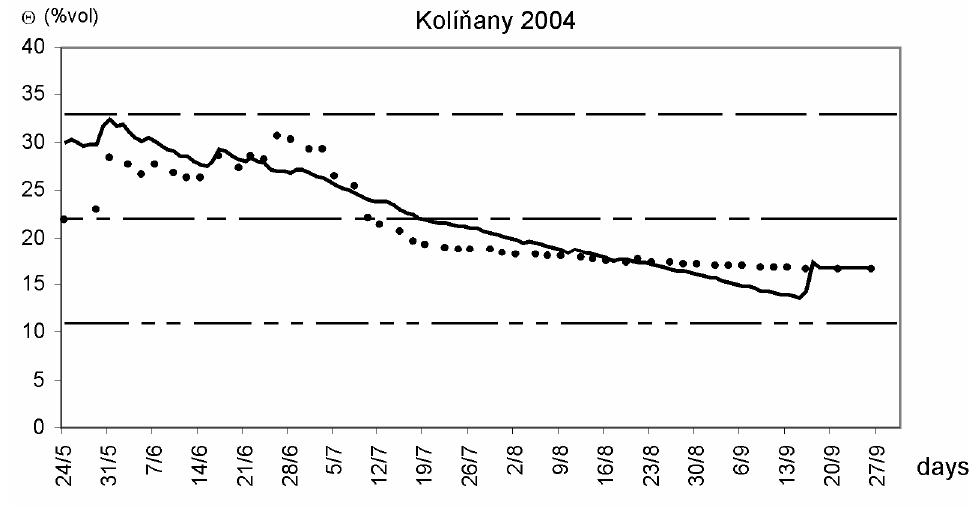
Fig 3. Measured and simulated values of volumetric soil water content in study area of Kolí ň any in